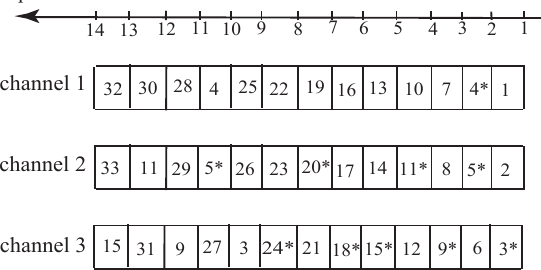
Figure 4. Static Channel Scheduling ( M = 3; τ = 3